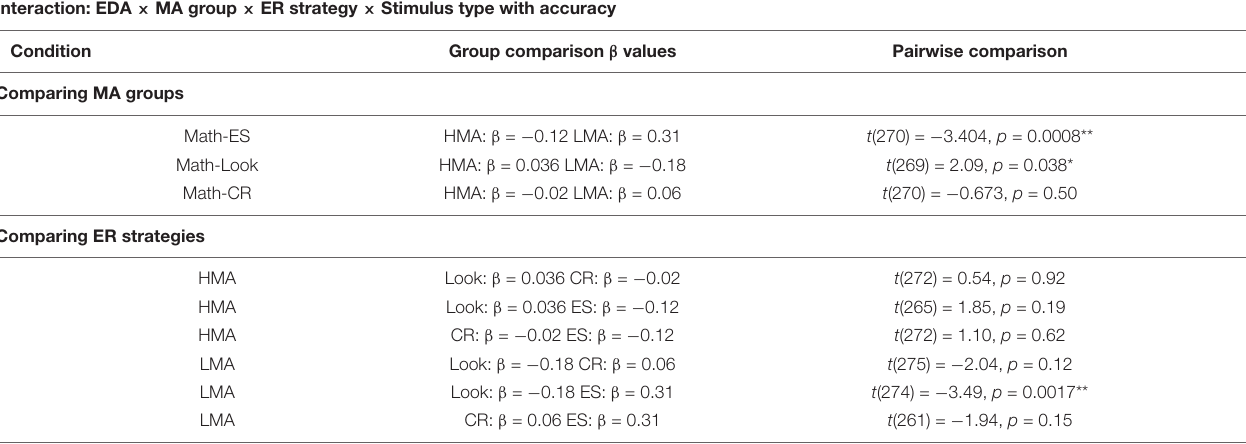
TABLE 3 | Pairwise comparisons in interaction between EDA, MA group, ER strategy, and stimulus type, with accuracy as an outcome measure. Interaction: EDA × MA group × ER strategy × Stimulus type with accuracy Condition Group comparison β values Pairwise comparison Comparing MA